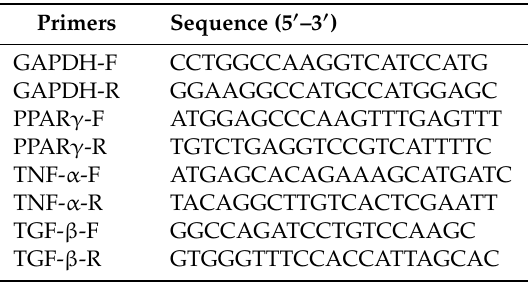
Table 2. Primers for